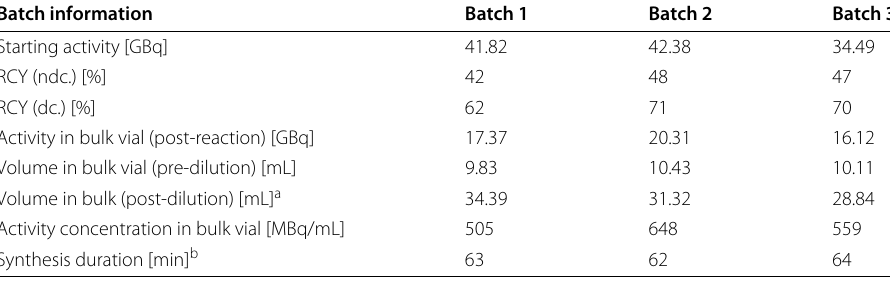
Table 4 Batch information: radioactivity parameters of the automated process Batch information Batch 1 Batch 2 Batch